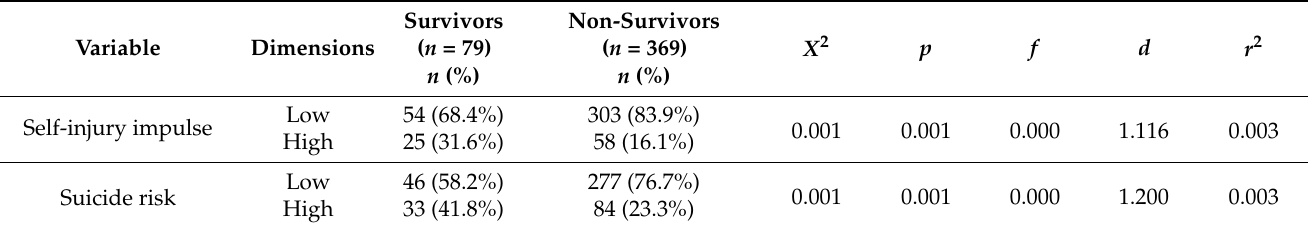
Table 4. Impulse for self-injurious behavior and suicidal risk in adolescents as a function of survivor status.